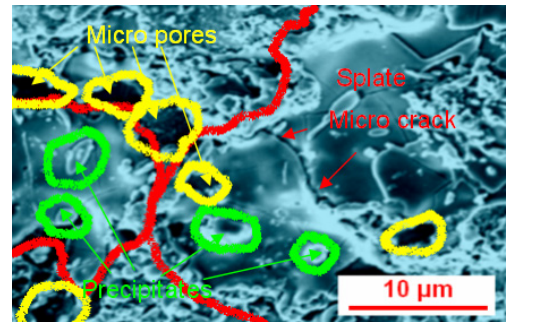
Figure 5 – (SEM) Surface of the Mo&O 2 coating Рис . 5 – (SEM) поверхность Mo&O 2 покрытия Слика 5 – (SEM) површина Mo&O 2